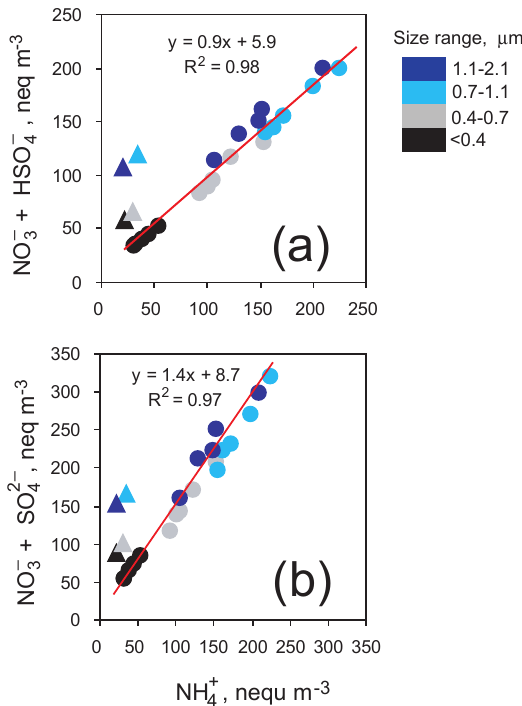
Fig. 12. Linear fit regression for ions in fine particles ( < 2.1µm) during the non-dust storm (circle symbols) and dust storm (24 April 2009, triangle symbols) periods in Figure 12. Linear fit regression for ions in fine particles (< 2.1 µ m) during the non-dust storm (circle points) and dust storm (April 24, 2009, triangle points) periods in Xi’an